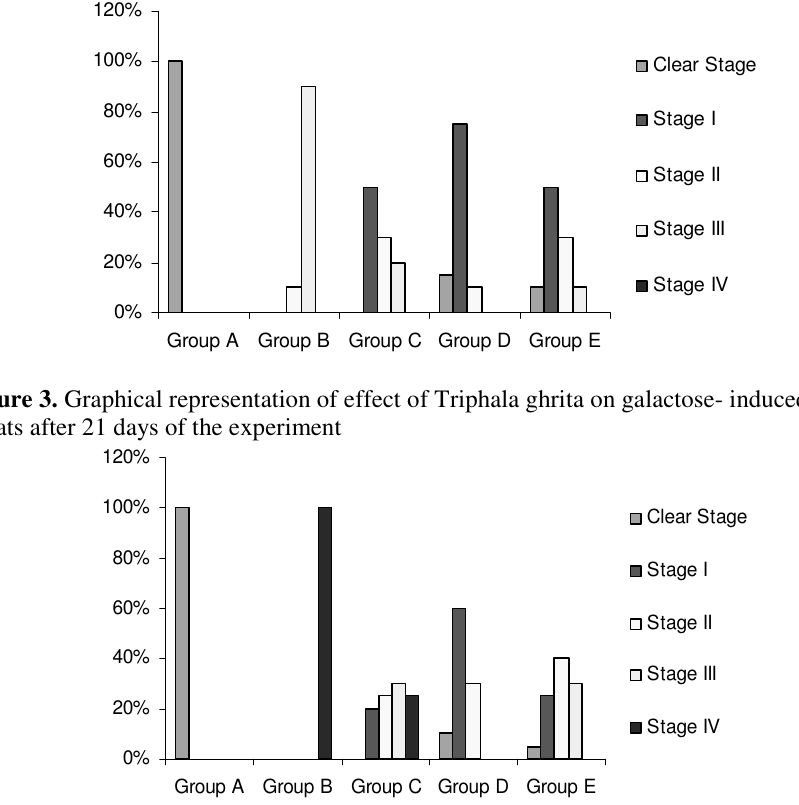
Figure 2. Graphical representation of effect of Triphala ghrita on galactose- induced cataract in rats after 14 days of the experiment